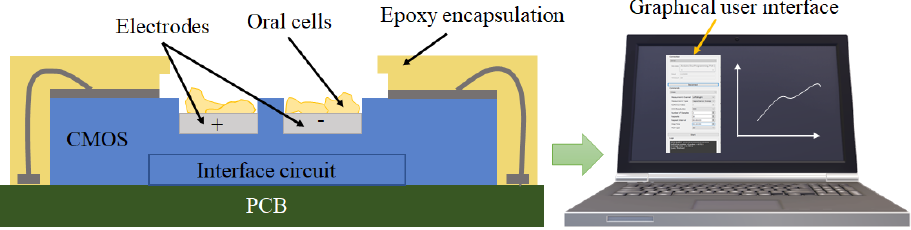
Figure 1. A CMOS-based capacitive sensor encapsulated with epoxy for oral cell monitoring.